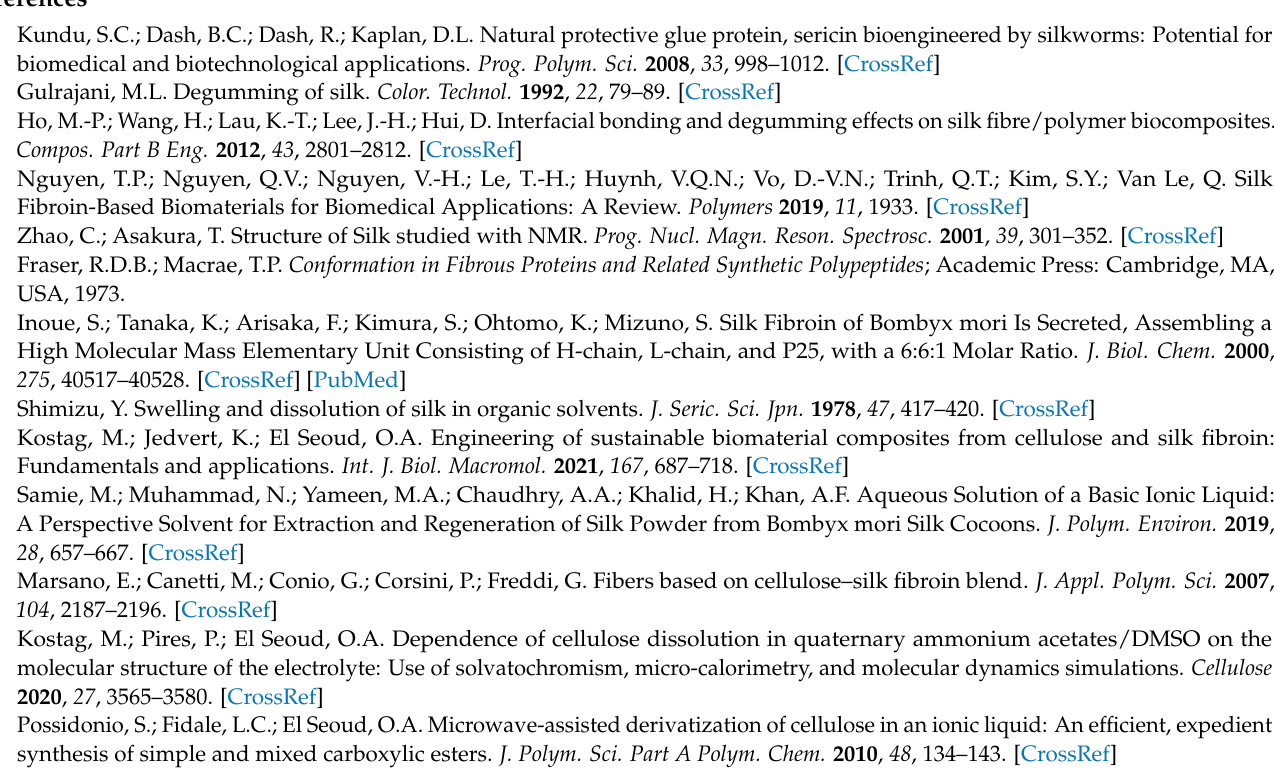
Table S2: Second-order polynomial fit of the dissolution data; Table S3: Dependence of ET(WB) on T at a fixed χ DMSO and on χ DMSO at a fixed